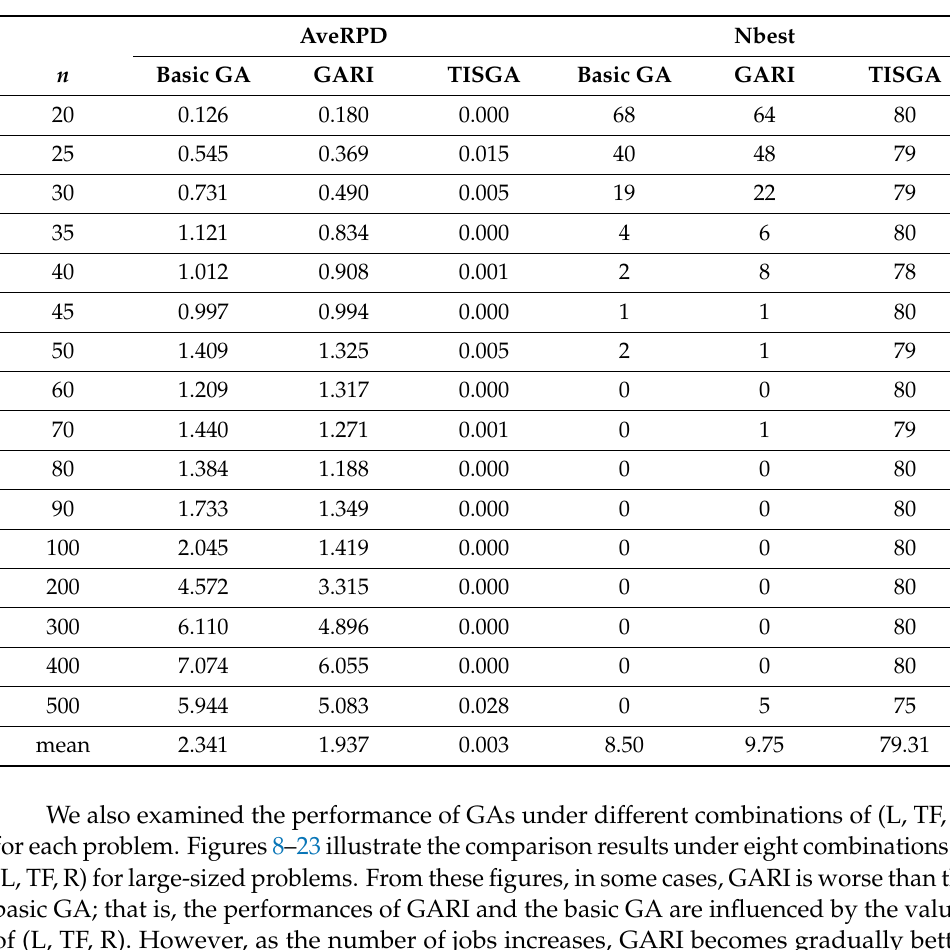
Figure 9. Comparison results for n = 25 with eight combinations of (L, TF, R).